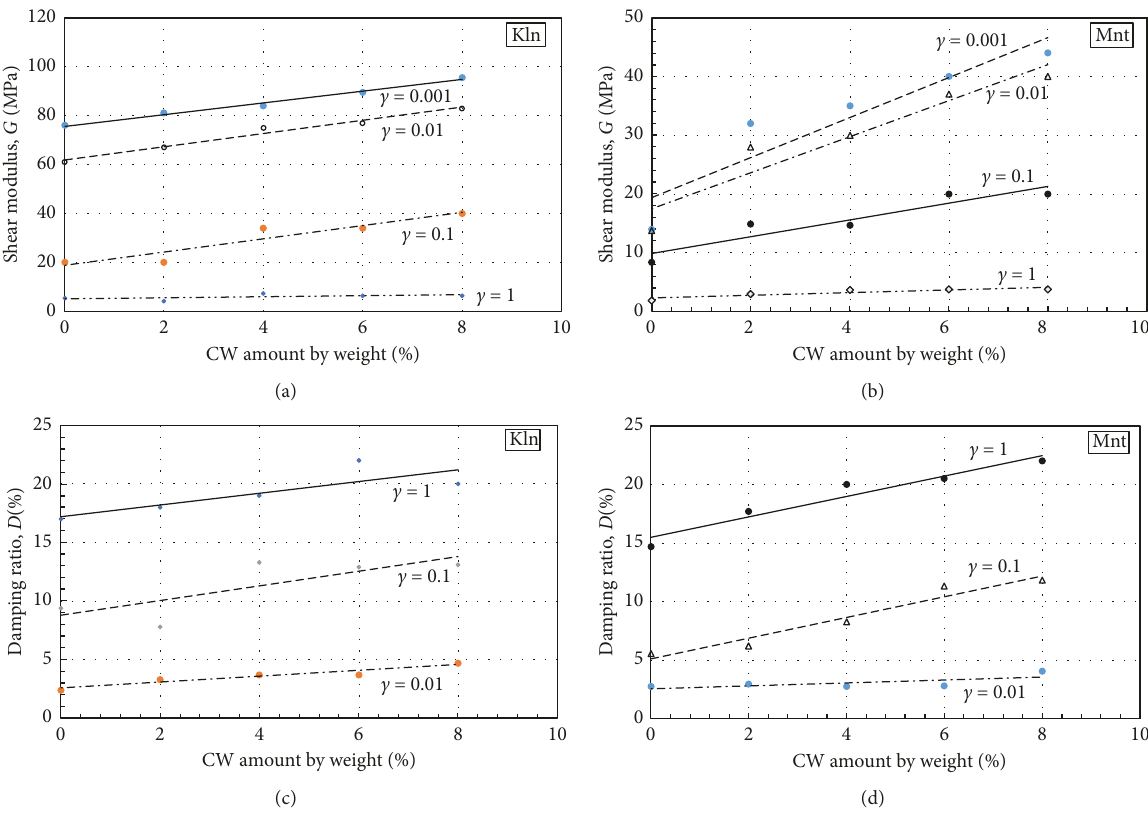
Figure 9: Change in shear modulus (a) and damping ratio (b) at different strain levels with respect to CW